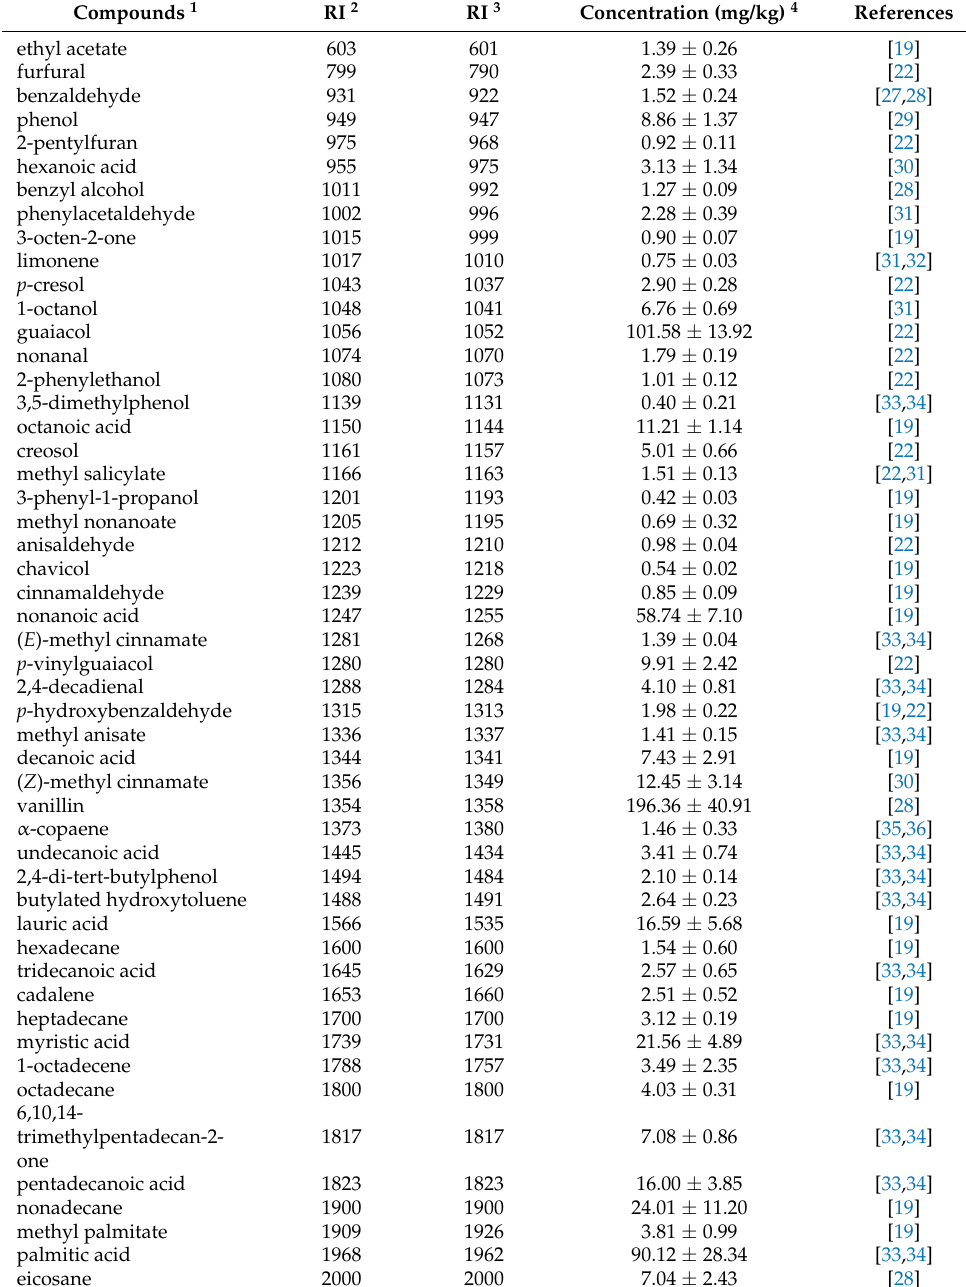
Table 3. SDE quantifies the volatile components of vanilla